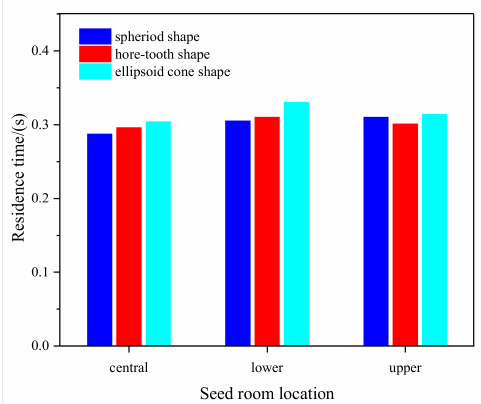
Figure 9. Average flow times of seeds in the seed-delivery system.